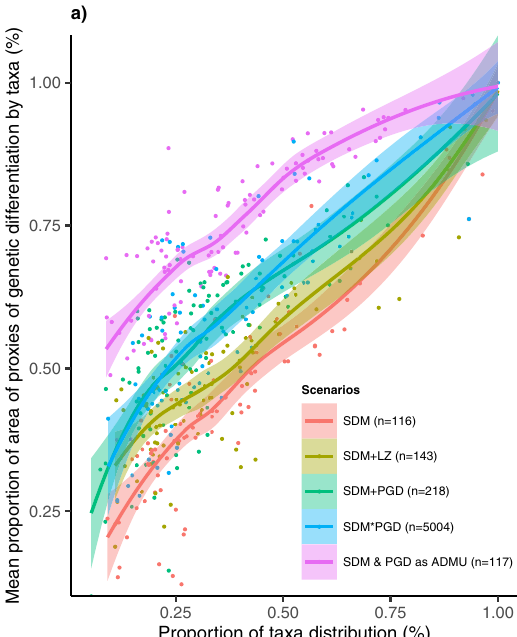
with potential distribution models and 102 proxies of genetic differentiation; (iv) SDM*PGD, considered 5004 conservation features, that resulted by subdividing each of the 116 potential distribution model by 102 proxies of genetic differentia- tion (as some combinations produced empty outputs given the extension of SDM that do not cover all of Mexico, we only used the layers with taxa information as conservation features); (v) SDM and PGD as administrative units (ADMU), con- sidered116taxawithpotentialdistributionmodelsasconservationfeaturesandthe proxies of genetic differentiation as one single layer considering 102 units of ana- lysis (we used the ADMU function that allowed to consider each proxy as an independent planning unit to guarantee the representation of taxa). Source data are provided as a Source Data fi